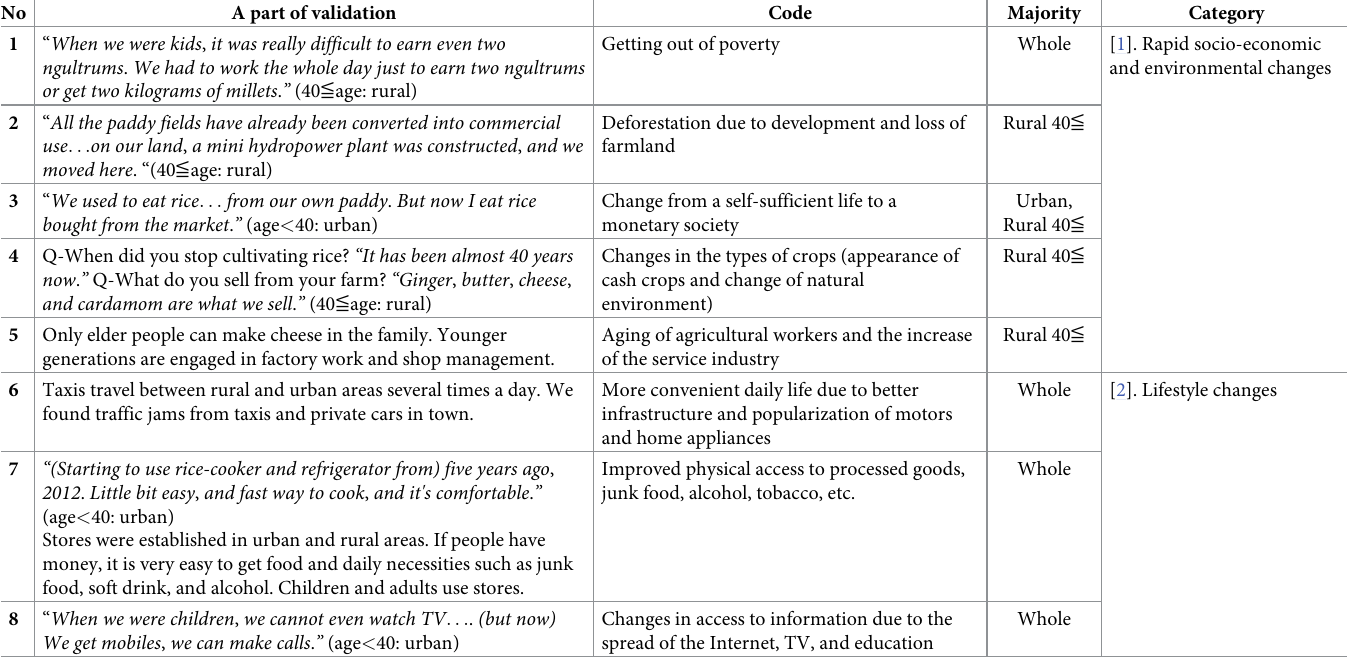
Table 4. Theme I: Rapid socio-economic changes: Validation, code, categories and